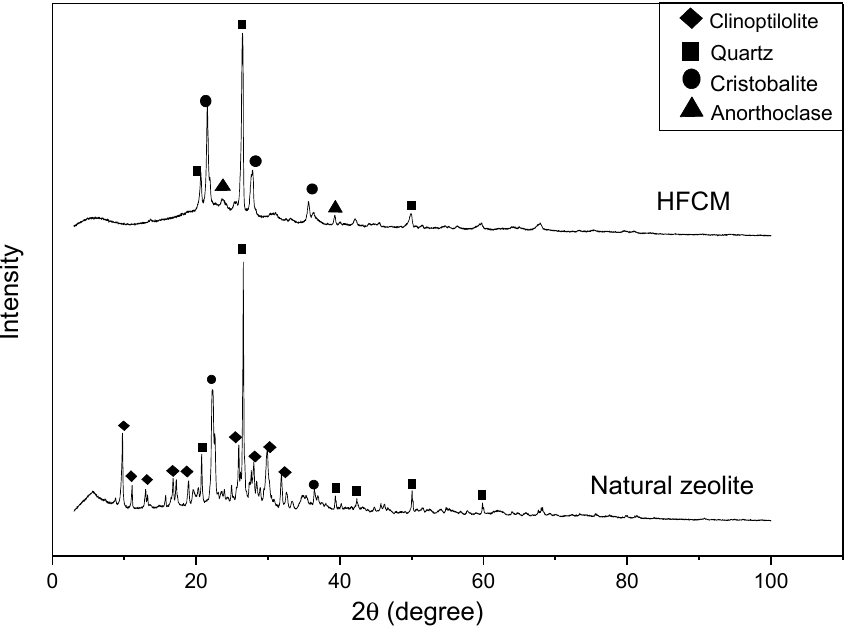
Figure 7. The X-ray di ff raction analysis (XRD) patterns of the natural zeolite and HFCM.